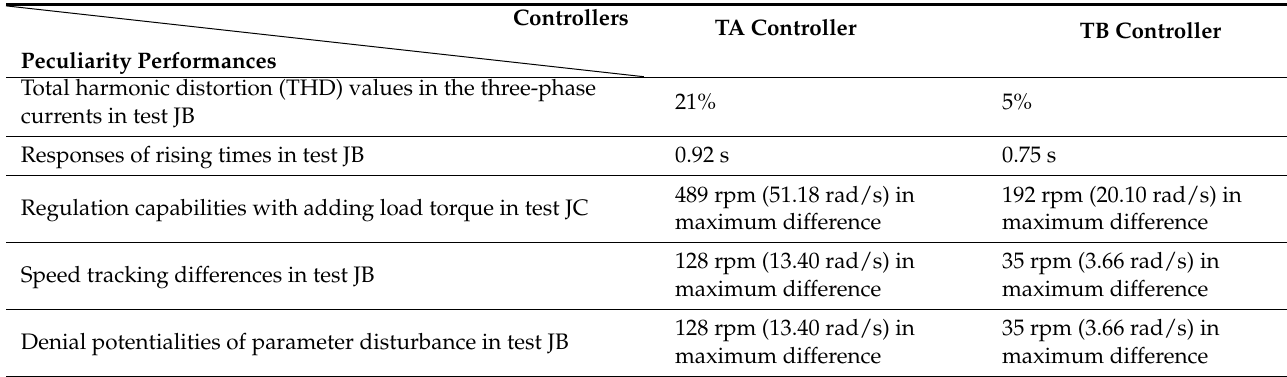
Table 2. Peculiarity performances for the two